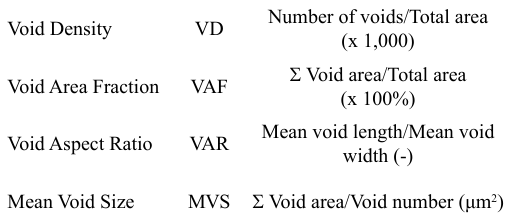
Table 2. Definitions of microvoids measures and